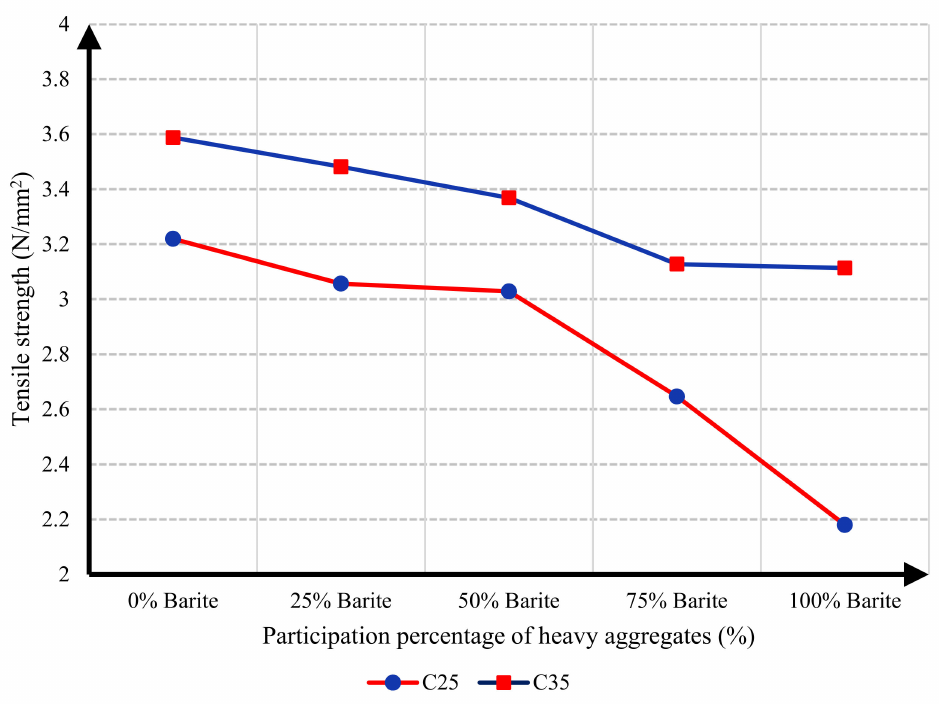
Figure 9. Diagram of the tensile strength of concrete specimens and participation percentage of barite aggregates for C25 and C35 concrete mixtures.